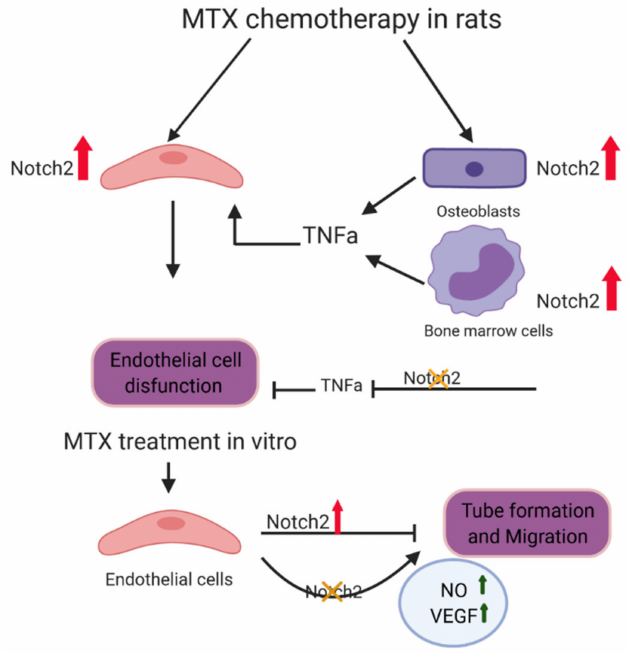
Figure 9. Schematic representation of function of Notch2 activation in endothelial cell and bone vasculature damages following MTX treatment. Activation of Notch2 in osteoblasts and bone marrow cells after MTX treatment may result in increased production and release of tumour necrosis factor alpha (TNF α ), which, together with Notch2 overactivation in endothelial cells, may cause vasculature dysfunction and vasodilation. Notch2 antagonism can significantly attenuate MTX treatment-induced micro-vasculature damage. MTX treatment in vitro also induces Notch2 pathway in cultured rat bone marrow endothelial cells (BMECs), which is linked with decreased tube formation and migration ability; and anti-Notch2 antibody treatment ameliorates MTX-induced adverse effects on BMEC functionality, which is possibly due to increased production of nitric oxide (NO) production and expression of vascular endothelial growth factor (VEGF) in endothelial